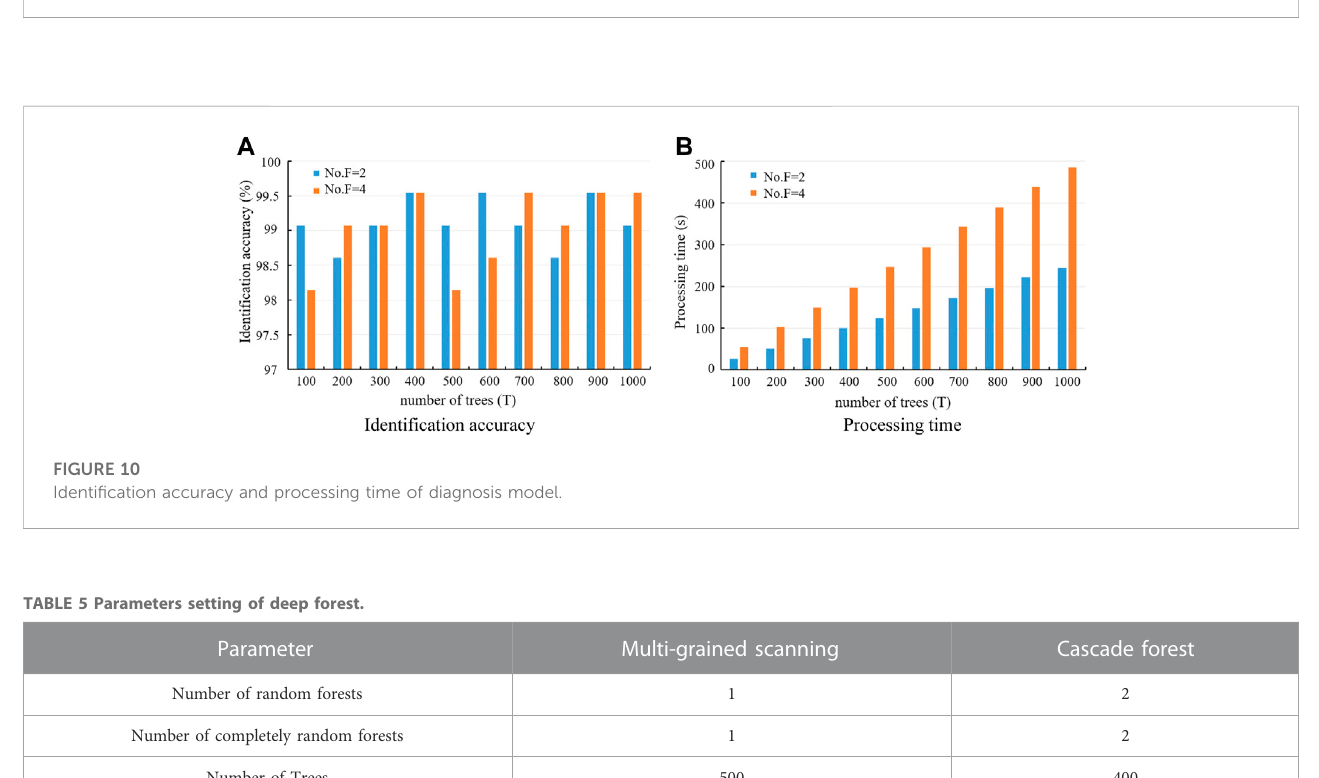
FIGURE 9 MPE of the vibration signals under six working conditions.